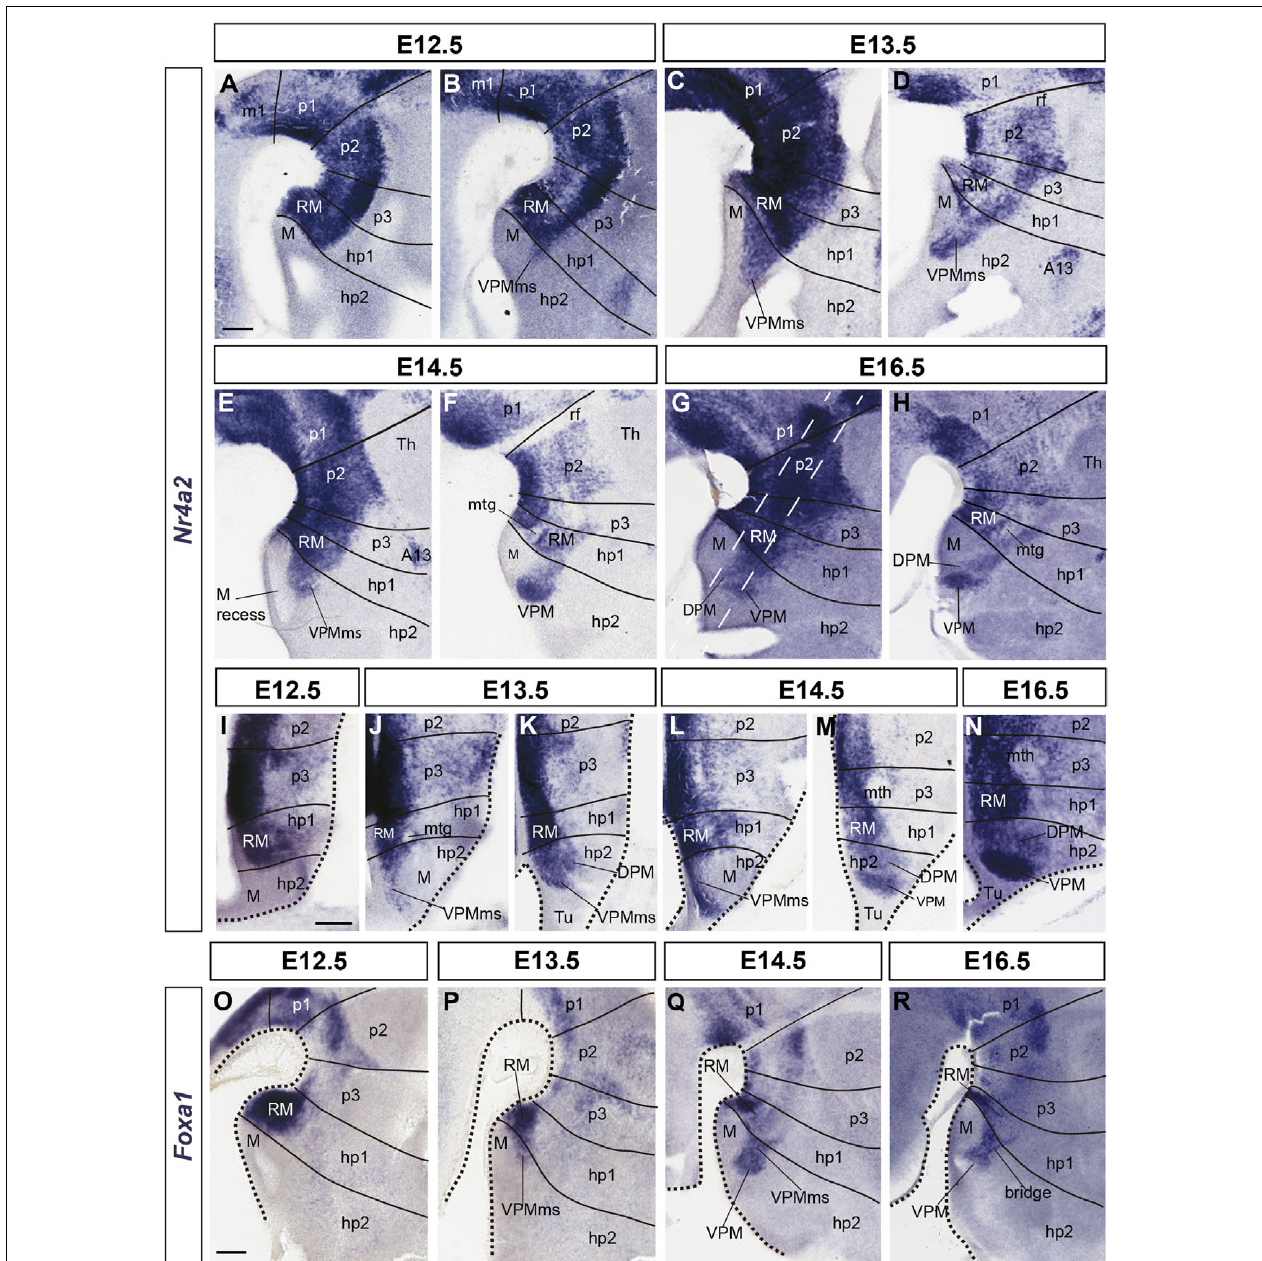
FIGURE 3 | Details of developmental progress of the VPMms and VPM nucleus. (A–H) Sagittal Nr4a2 ISH sections between E12.5 and E16.5. (I–N) Horizontal Nr4a2 ISH sections between E12.5 and E16.5. (O–R) Sagittal Foxa1 ISH sections between E12.5 and E16.5. Black lines mark hypothalamic, diencephalic, and rostral mesencephalic interprosomeric limits (units hp2, hp1, p3, p2, p1, m1), perpendicular to longitudinal references, here to the floor plate (compare Figure 1C ). In (A–H) each embryonic day is represented by two sagittal sections, the first one being medial to the other. The section planes of the horizontal Nr4a2 sections (particularly J–M ) are indicated with white dash lines in (G) . In duplets of horizontal sections of the same embryonic day, the ventral section crossing the mamillary area (J,L) is followed by a more dorsal section through the main VPMms (K,M) . (O–R) These sagittal sections labeled with Foxa1 ISH reveal that this marker predominates in the ventral part of RM (compare with Nr4a2 signal in A–H ). Scale bars represent 200 µ